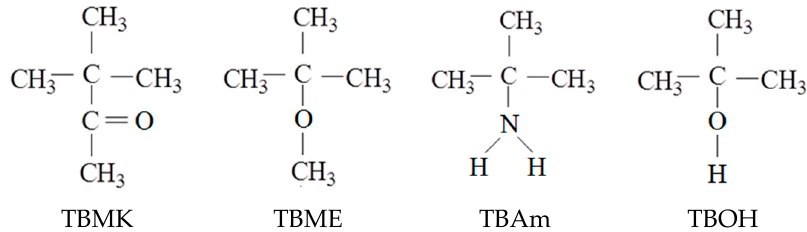
Figure 1. Structural formulae of t -butyl methyl ketone (TBMK); t -butyl methyl ether (TBME); t -butylamine (TBAm); and t -butanol (TBOH).